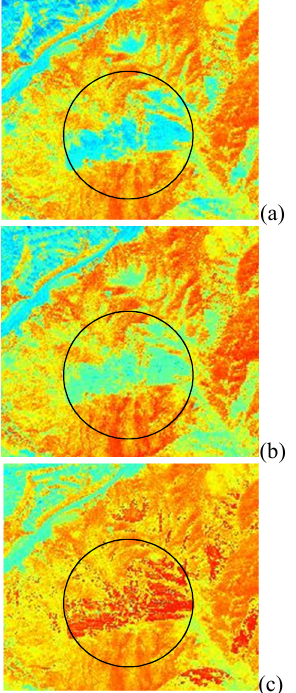
Figure 12. NDVI of Ma On Shan - a) Original image; b) By Gamma Correction; c) By Linear-Correlation